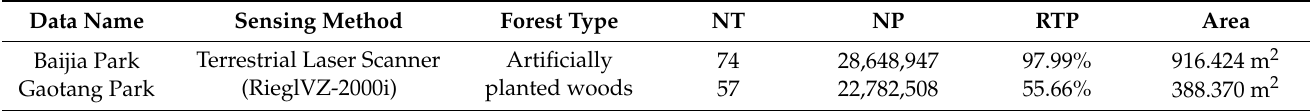
Table 1. Detailed parameters for the test set of our two self-built datasets.